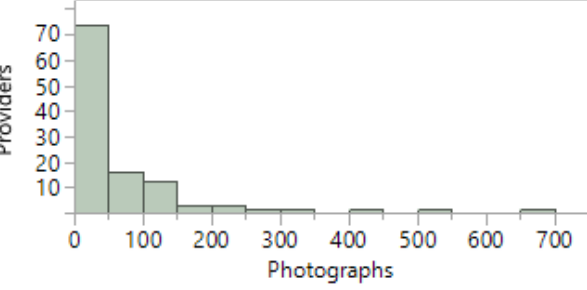
Figure 6. Distribution of provider experience with photography. A single outlier who captured over 1000 photographs is not included on the histogram.